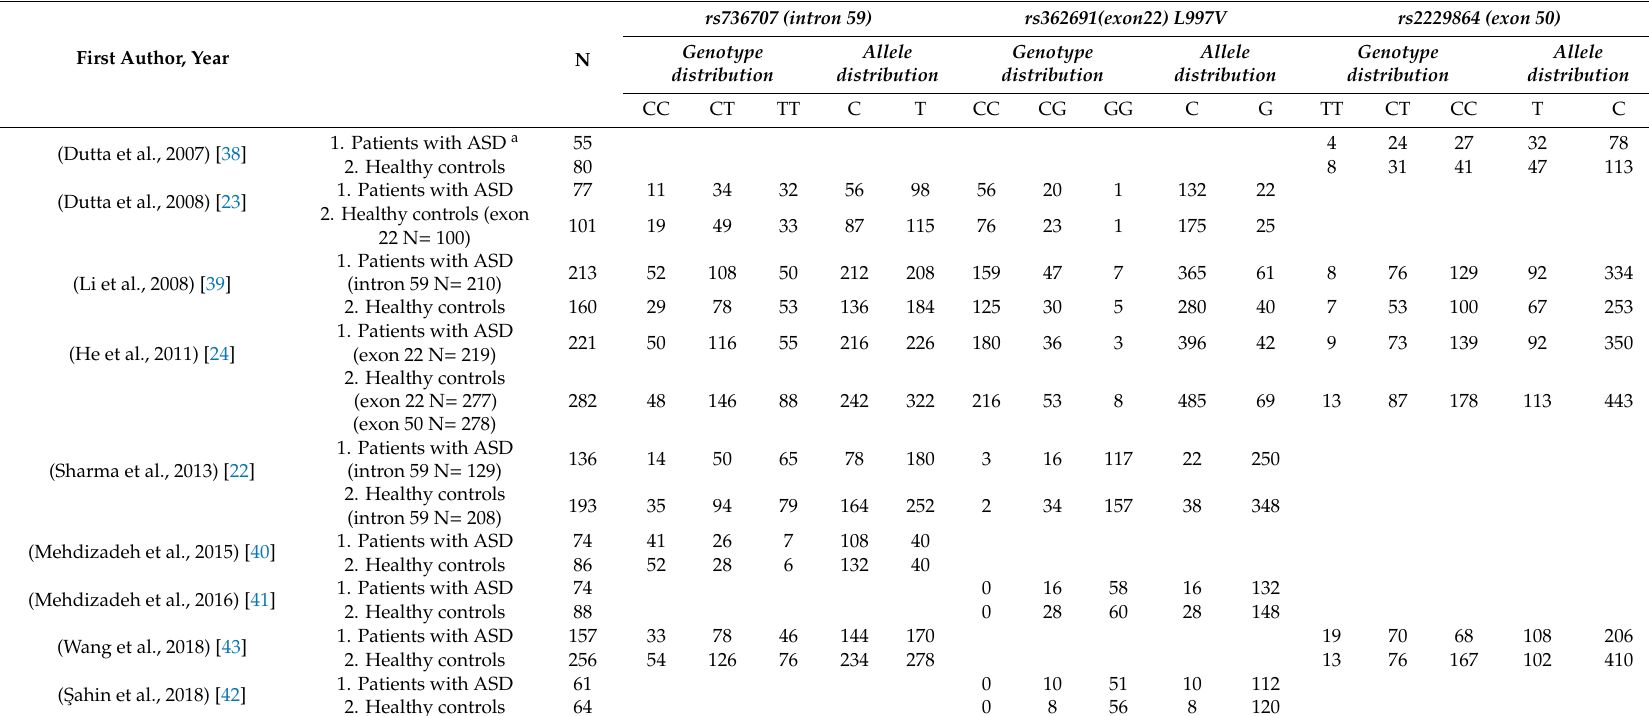
Table 3. Genotype and allele distribution: intron 59, exon 22, and exon